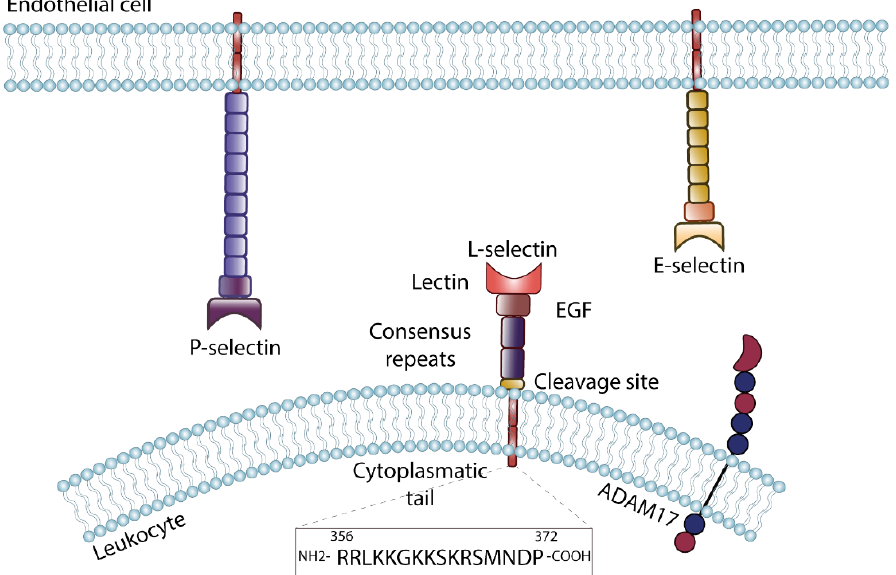
Figure 2. Selectin structure and expression. The selectin family consists of three members: E-selectin is expressed on the surface of activated endothelial cells, P-selectin occurs on endothelial cells as well as on platelets. L-selectin is expressed on leukocytes and can be shed by specific enzymes including A disintegrin and metalloproteinase 17 (ADAM17). Selectins share a common structure, characterized by an N-terminal C-type lectin domain, followed by an epidermal-growth-factor-like domain (EGF) and a number of consensus repeats, which is characteristic for each selectin. The transmembrane domain is followed by a short cytoplasmic tail. The cytoplasmic tail of L-selectin (amino acid sequence shown at the bottom) is highly conserved between species and is able to fulfill signaling function.